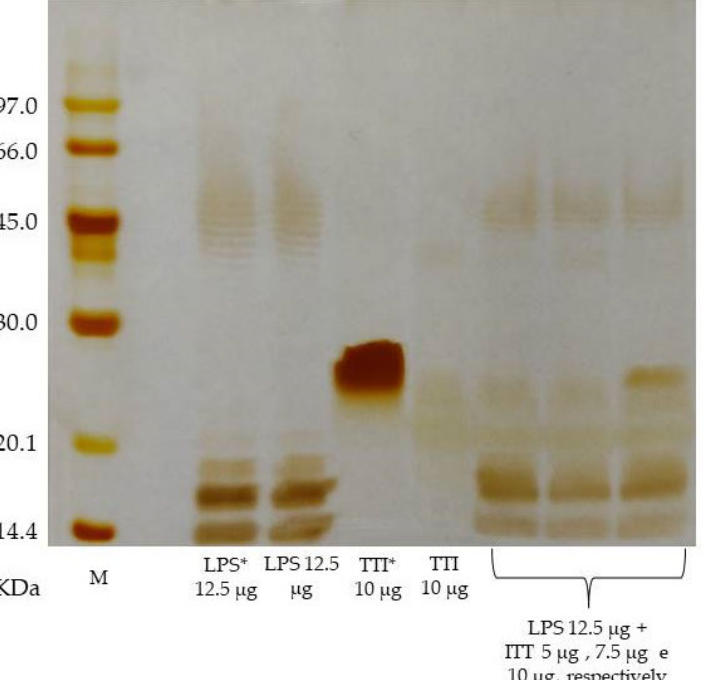
Figure 3. A 12.5% SDS-PAGE, showing the profiles of TTI, LPS, and the product of the incubation of both at 37 °C. The lipopolysaccharide used was obtained from Escherichia coli O55:B5 (Sigma ‐ Aldrich ® ). The gel was stained with silver [34]. LPS: lipopolysaccharide; M: marker; TTI: trypsin inhibitor isolated from tamarind seed. (*) Aliquots applied to the gel in the same amounts used in the assay, but without